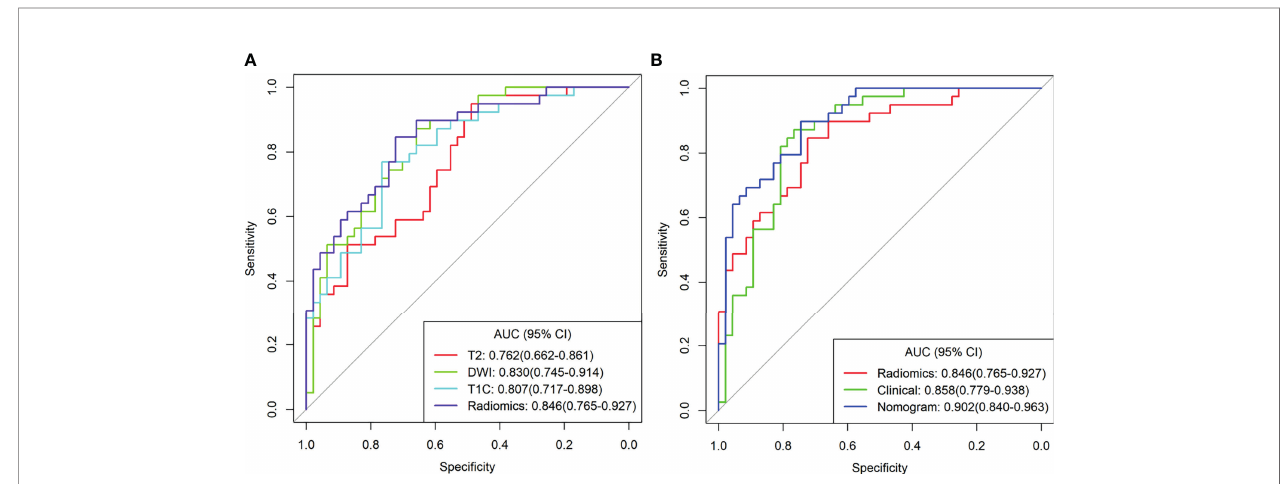
FIGURE 3 | (A) T2WI radiation model, DWI radiation model, T1C Radiation Model, and combined radiation model. (B) Clinical Model, combined radiological model, and Nomogram Receiver Operating Characteristic